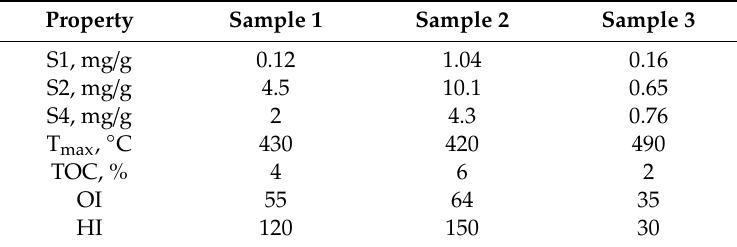
Table 4. Maturity Assessment of the actual downhole